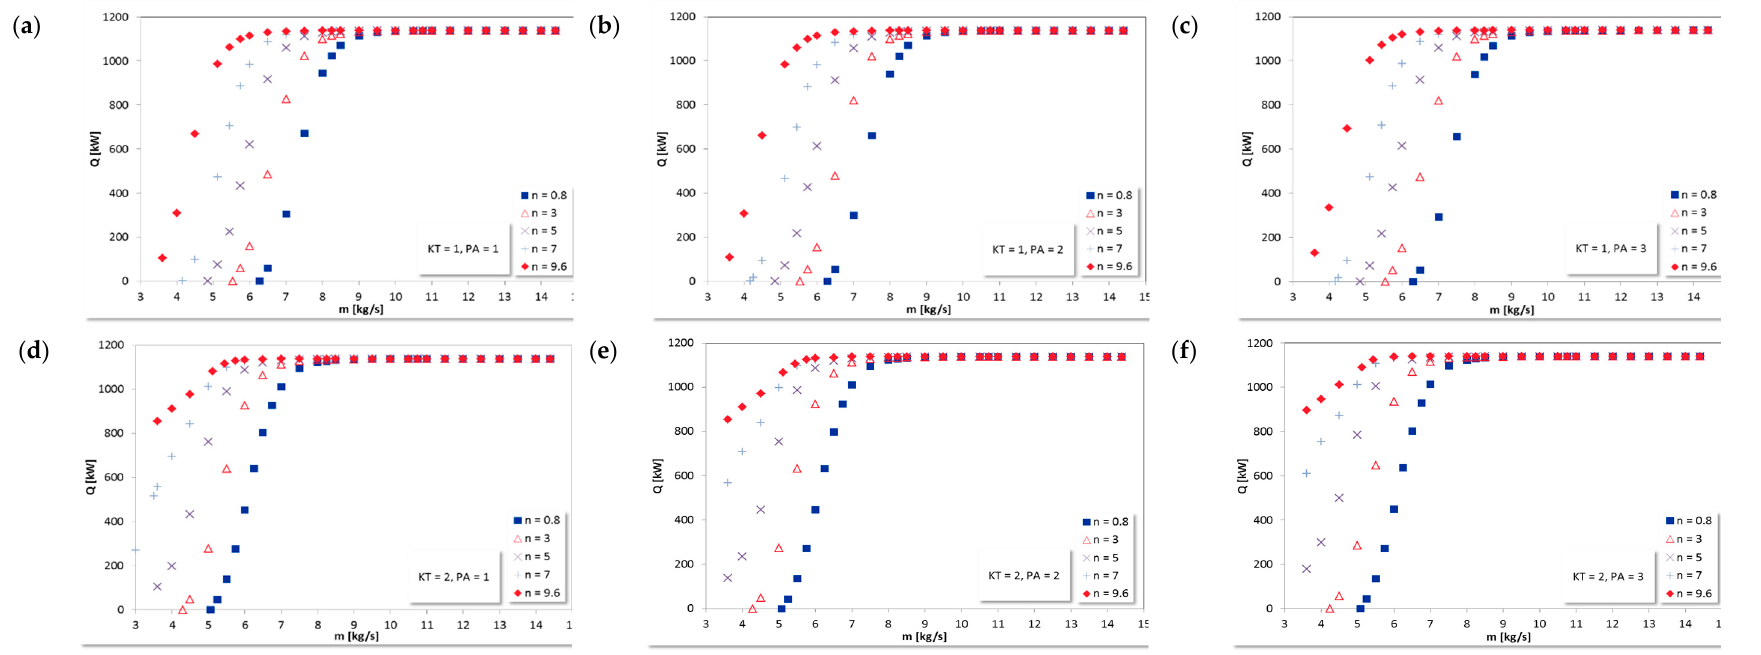
Figure 9. Influence of mass flow rates m and the number n of flooded tube rows on the total heat transfer rate of the evaporator, for plain tubes (KT = 1—the top row) and enhanced tubes Turbo B tubes (KT = 2—the bottom row). ( a ) KT = 1, PA = 1, ( b ) KT = 1, PA = 2, ( c ) KT = 1, PA = 3, ( d ) KT = 2, PA = 1, ( e ) KT = 2, PA = 2, ( f ) KT = 2, PA = 3.